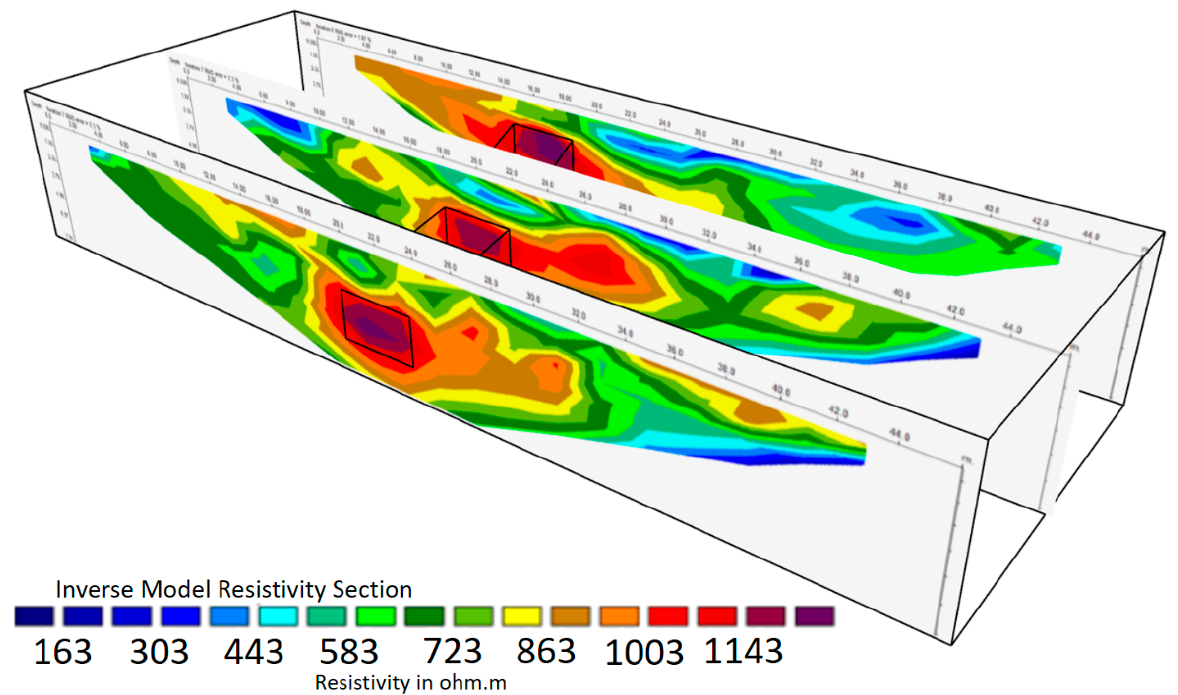
Figure 6. 2.5D simulated diagram of three survey